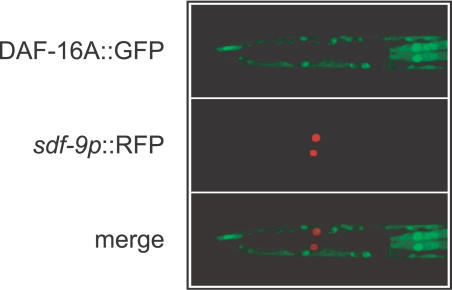
A Functional DAF-16A::GFP Fusion Protein Is Not Expressed in XXXWild-type animals harboring integrated DAF-16A::GFP and sdf-9p::RFP arrays were analyzed by confocal microscopy. Representative photographs of a single animal are shown. The animal is oriented anterior left and dorsal up. Merging of GFP and RFP images reveals no colocalization of fluorescent proteins.